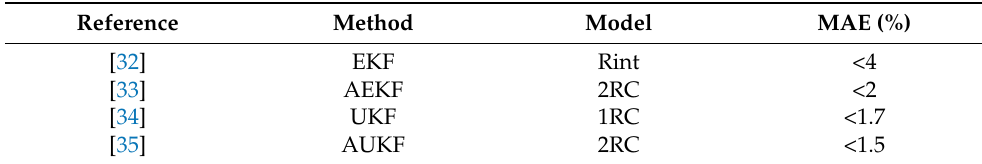
Table 2. Comparison of different SOC estimation